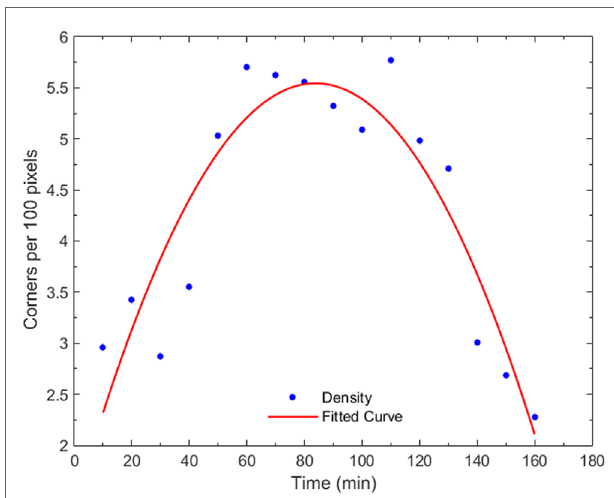
FIGURe 7 | Plot of corner density with time, for a dividing cell and one of its daughter cells . In early mitosis, the corner density increases substantially ( t = 50–80 min) since the cell becomes round with high- frequency internal details. At the cytokinesis stage, the density drops while, post-mitosis ( t = 140 min), the density drops to non-dividing value because the cell